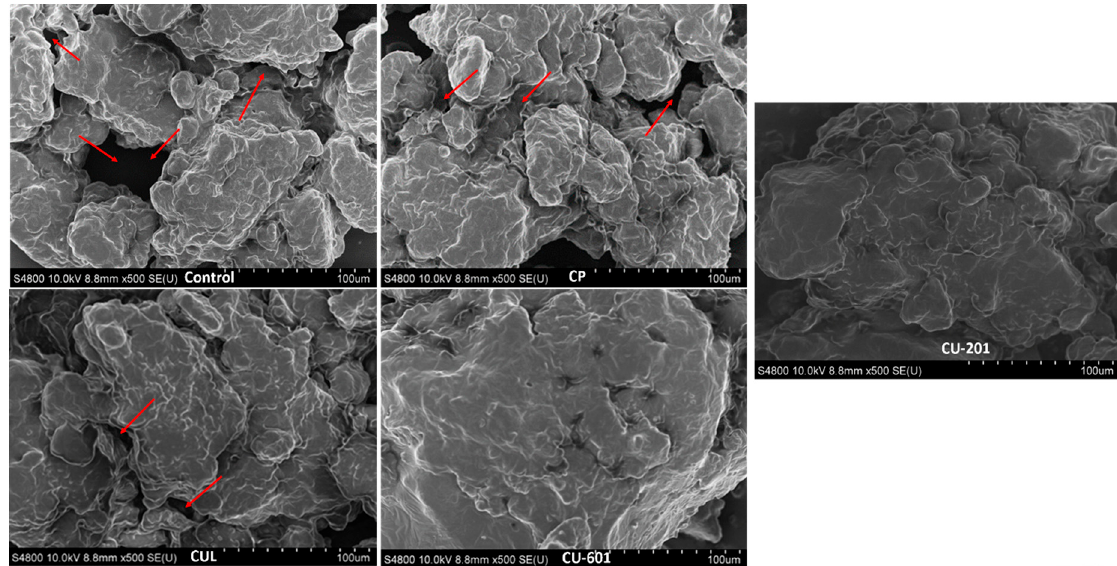
Figure 5. Microstructure of cookies prepared with pectin, with different molecular structures and molecular weights. CUL, CP, CU-601, and CU-201 indicate the names of pectin which were added in cookies. Red arrows show the interstitial spaces within matrix.